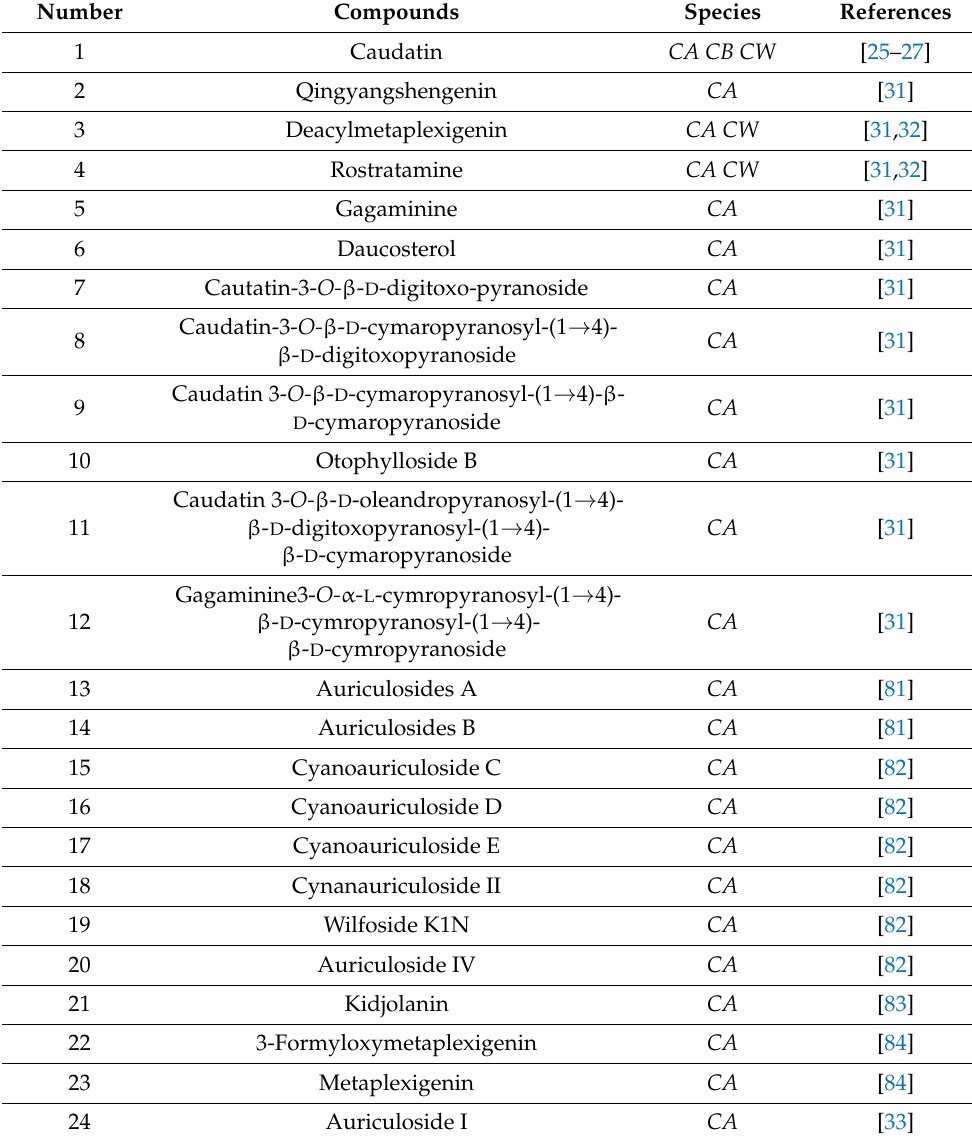
Table 1. C 21 -steroids glycosides compounds isolated from CA , CB and CW